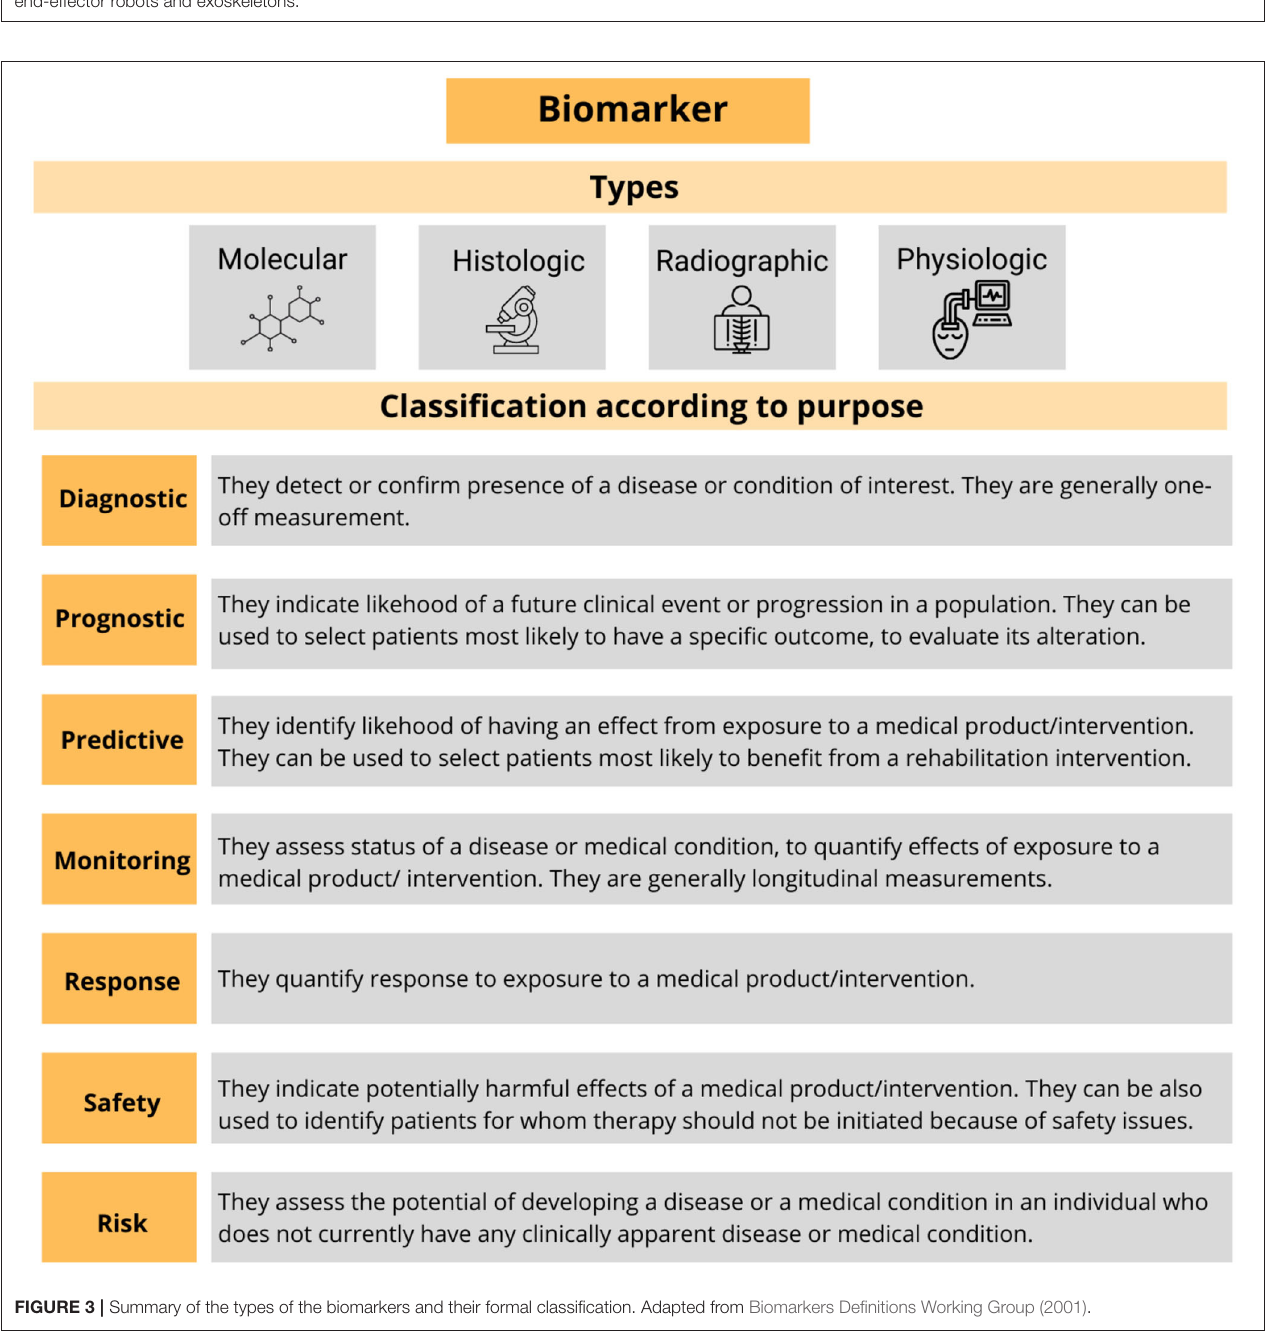
FIGURE 2 | panel), ranging from electrical stimulation to haptics, electromyography (EMG)-based assistance, and virtual reality, in order to support the rehabilitation training program (bottom panel). Training program includes the assessment sessions to tune and monitor the specific treatment, aimed at promoting the motor